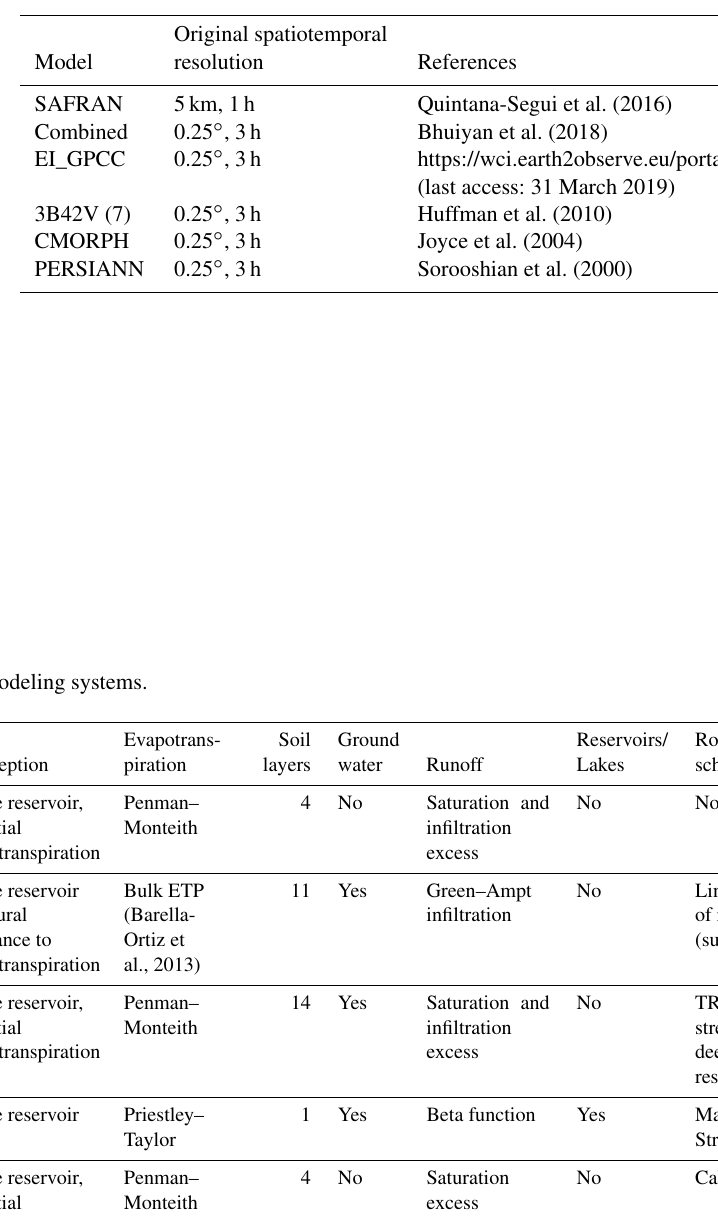
Table A1. Information on precipitation products used.